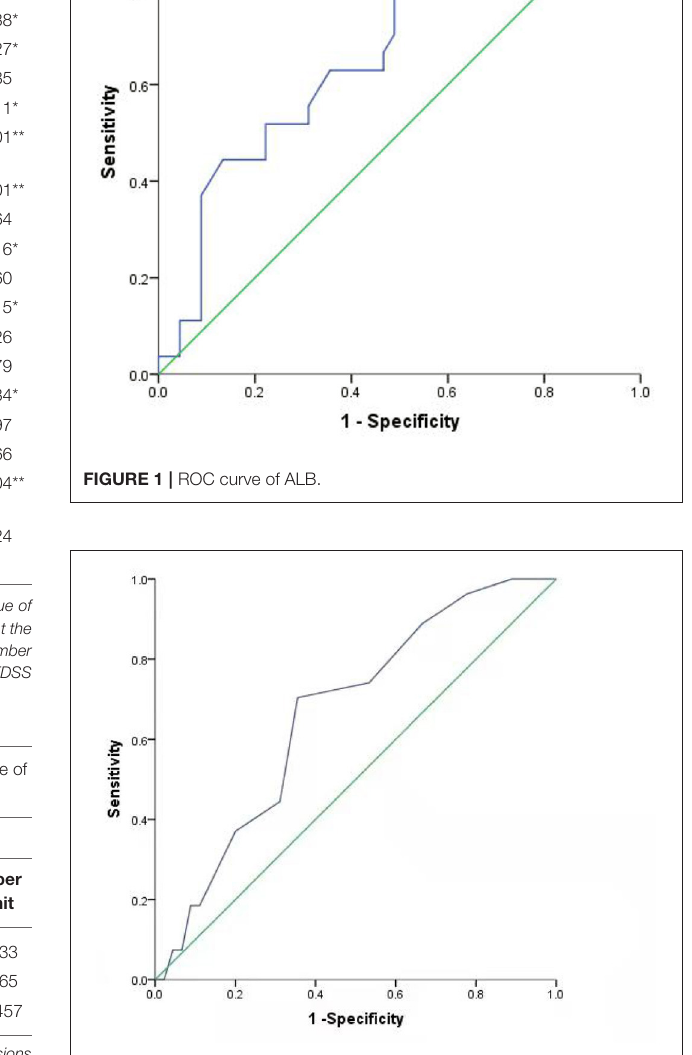
FIGURE 2 | ROC curve of total number of